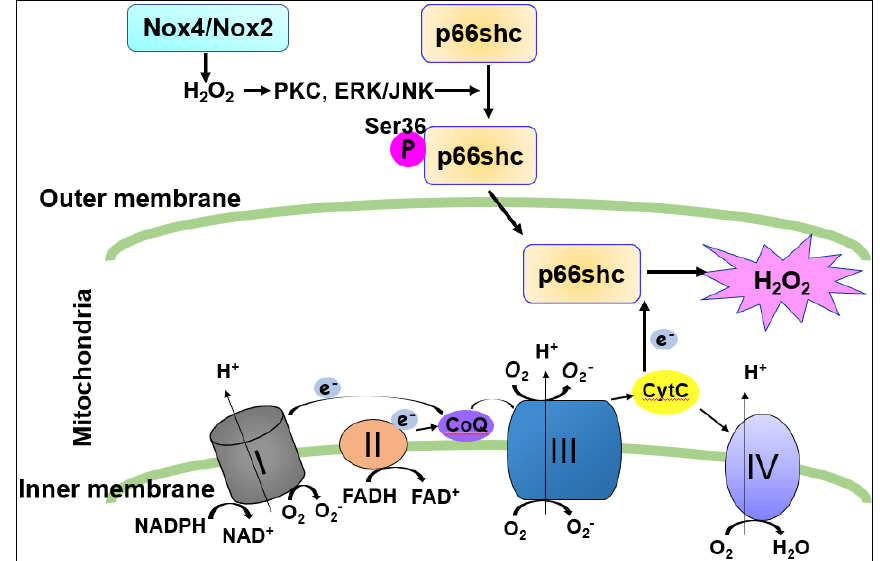
Figure 5. Mitochondrial H 2 O 2 production via the Nox4/Nox2/p ‐ p66Shc axis.